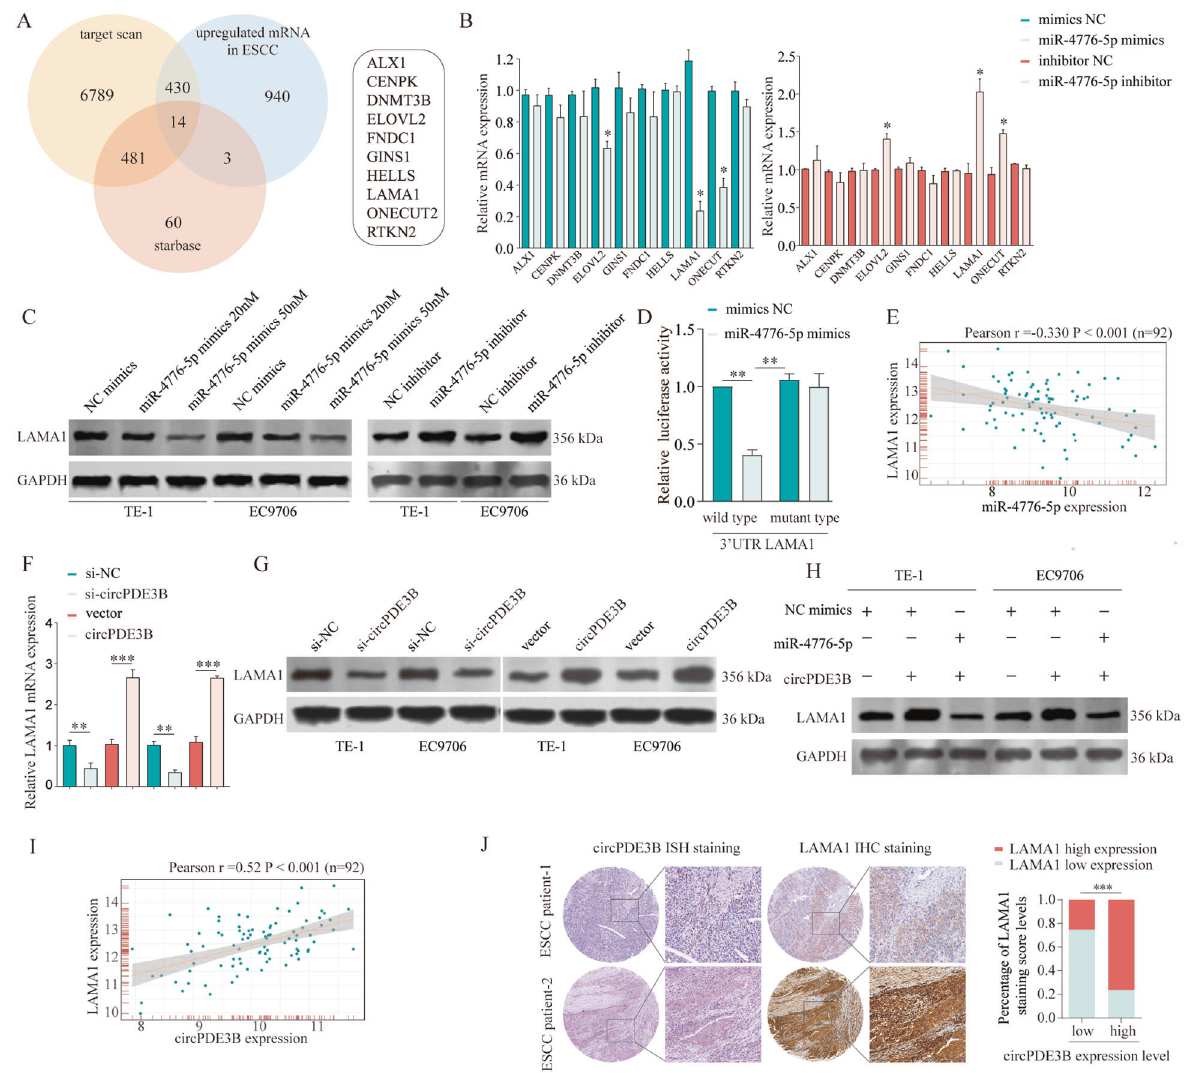
Fig. 6 circPDE3B indirectly enhances LAMA1 expression through sponging miR-4766-5p. A The intersection of mRNAs potential targeting by miR-4766-5p predicted by Targetscan, Starbase, and mRNAs upregulated in TCGA ESCC database is shown via Venn diagram. B The relative expression of candidate mRNAs in EC9706 cells was analyzed by qRT-PCR after transfected miR-4766-5p mimics or inhibitors, respectively. C The relative protein expression of LAMA1 in TE-1 or EC9706 cells was analyzed by western blot after transfected miR-4766-5p mimics or inhibitor, respectively. D Cells were transfected with a luciferase reporter plasmid containing wide-type or mutant-type 3 ′ UTR sequence of LAMA1, together with or without miR-4766-5p. The relative luciferase activity was analyzed. E Correlation analysis of LAMA1 and miR-4766-5p in ESCC patients ’ tissues. F , G The expression of LAMA1 in ESCC cells was analyzed by qRT-PCR or western blot after transfected circPDE3B siRNA or vector, respectively. H The expression of LAMA1 in ESCC cells was analyzed by western blot after circPDE3B overexpression with or without miR-4766-5p mimics transfection. I Correlation analysis of LAMA1 and circPDE3B in ESCC patients ’ tissues. J Co-expression of LAMA1 and circPDE3B in ESCC tissues were determined by IHC or ISH staining, respectively. * p < 0.05, ** p < 0.01, *** p < (Fig. 7E). Moreover, patients with high LAMA1 expression had reduced mean days of OS and DFS compared with patients with low LAMA1 expression (Kaplan – Meier survival analysis, Fig. 7F).